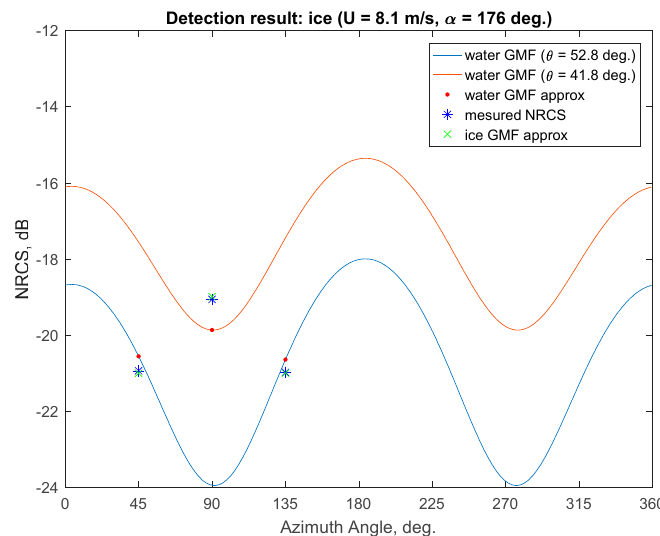
Figure 7. An example of water GMF approximations from the simulated “measured” NRCSs, with water GMF curves for incidence angles of 41.8° and 52.8°, and the sea ice GMF approximations.